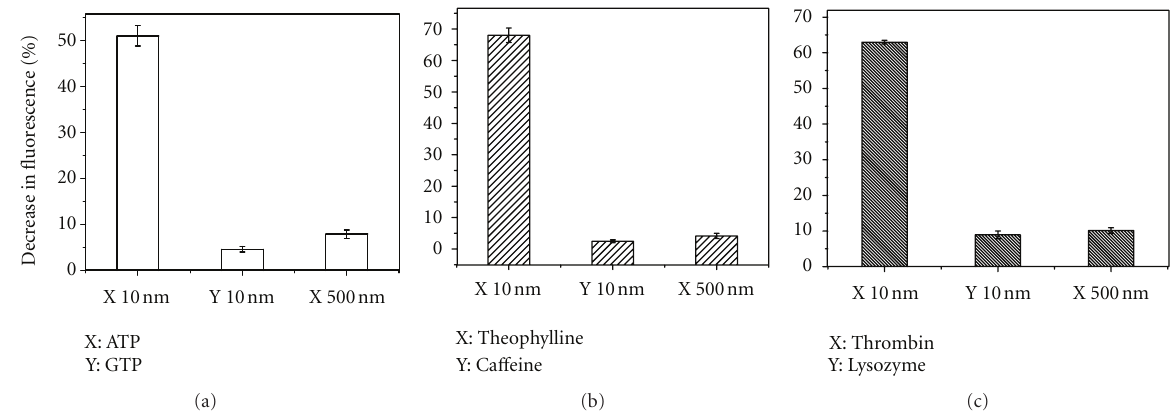
Figure 7: Specificity of signaling strategy towards aptamer and cognate target. Chromophores used for the (a) ATP, (b) theophylline, and (c) thrombin aptamers, respectively, were Hoechst 33258, TO, and YOYO. Change of fluorescence is the di ff erence in fluorescence intensities of chromophores (25nM) with 10nM aptamers and presence or absence of indicated amounts of